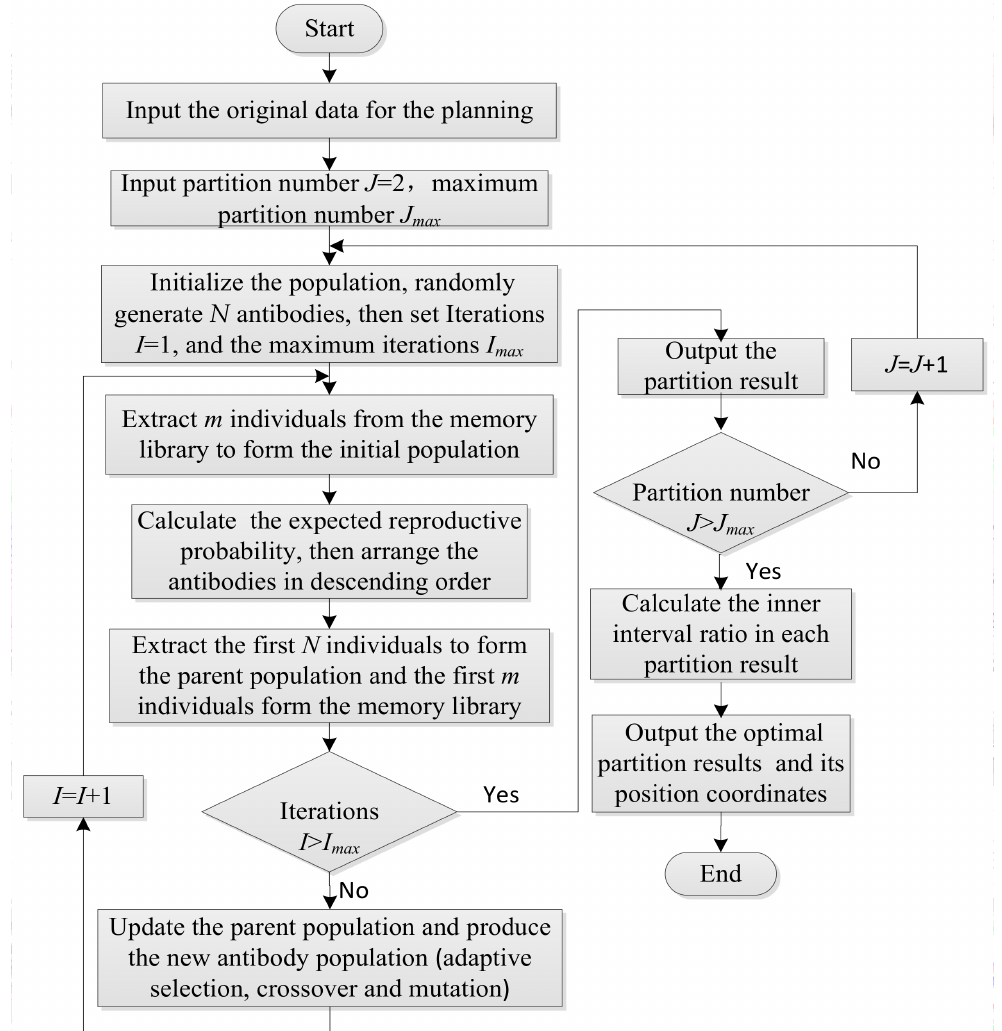
Figure 3. A flow chart of the integrated energy supply centre’s optimization location based on an improved adaptive evolutionary immune